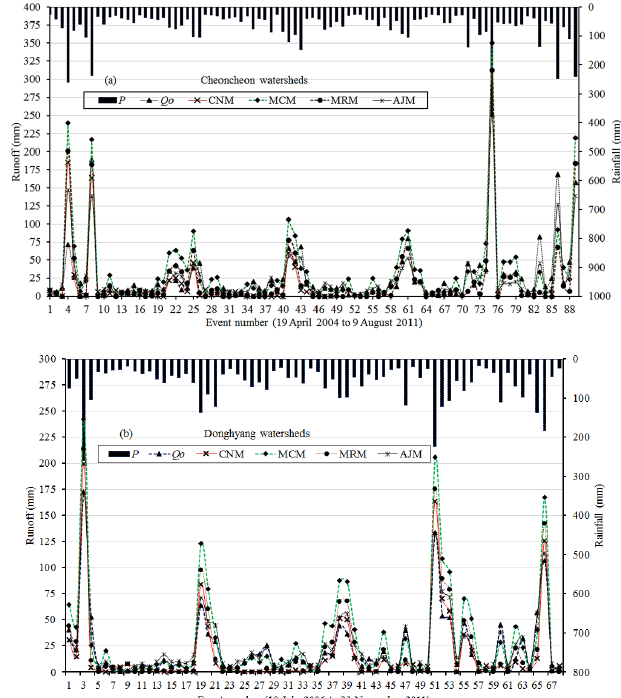
application of four models for ( a ) Cheoncheon watershed; and ( b ) Donghyang watershed.